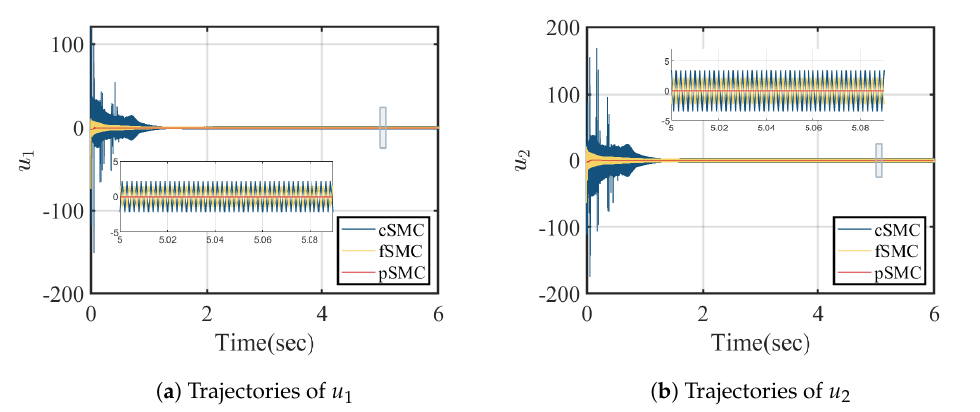
Figure 15. The trajectories of control variables u 1 and u 2 with continuous approximation in control when ρ b = 0.6: cSMC (Blue solid line), fSMC (Yellow solid line) and pSMC (Red solid line).